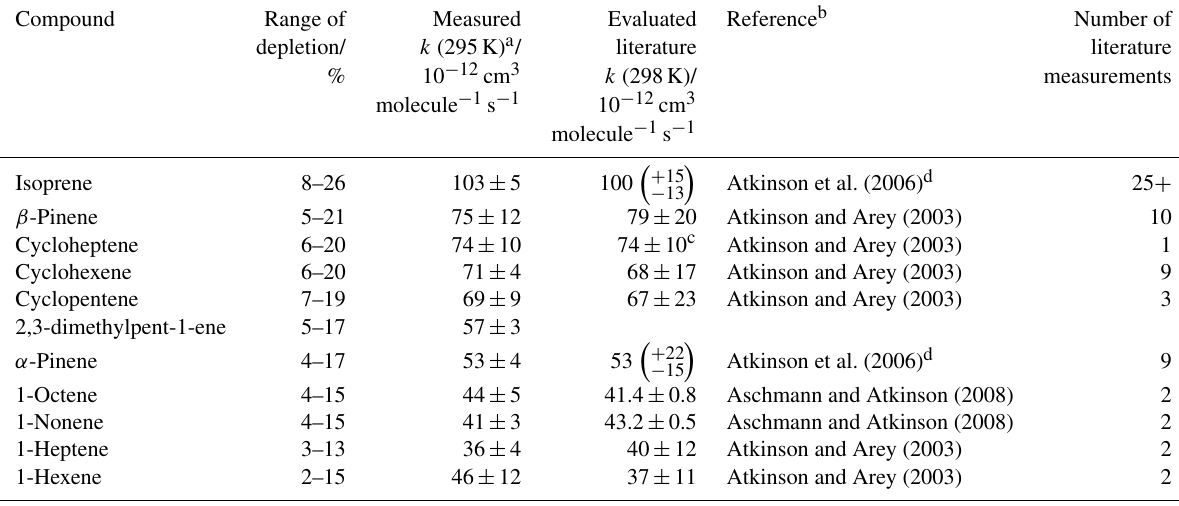
Table 2. Results of relative rate experiments, with literature data, for each VOC in Mixture 2, ordered by measured k value. Compound Range of Measured Evaluated Reference b Number of depletion/ k (295K) a / literature literature measurements